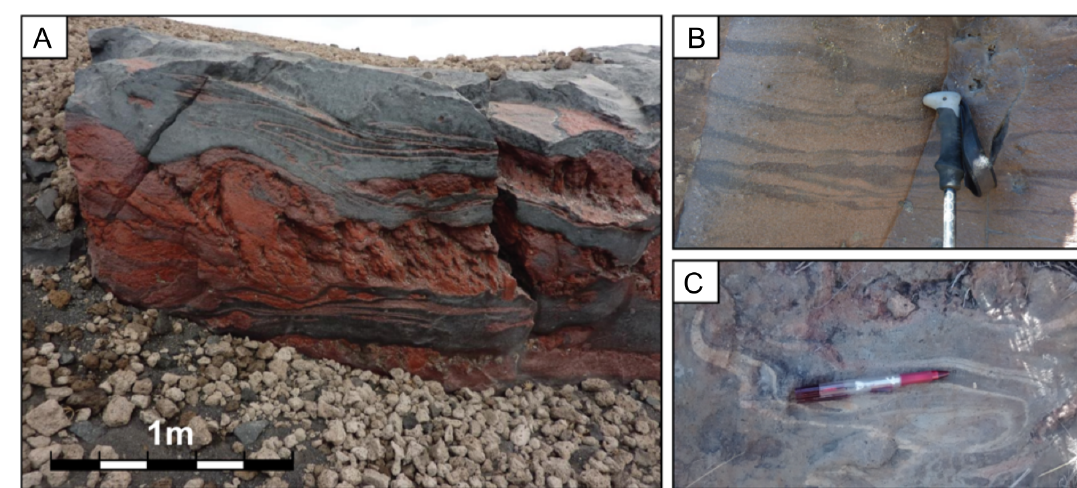
Figure B.1: Mingling textures in PVC lavas on various scales. [A] Proximal Ventorrillo lava. [B] Chipiquixtle lava. [C] San Pedro lava. Photograph of mingled lava belonging to the proximal Ventorrillo cone. Photographs [A] and [B] by C. M. Petrone.